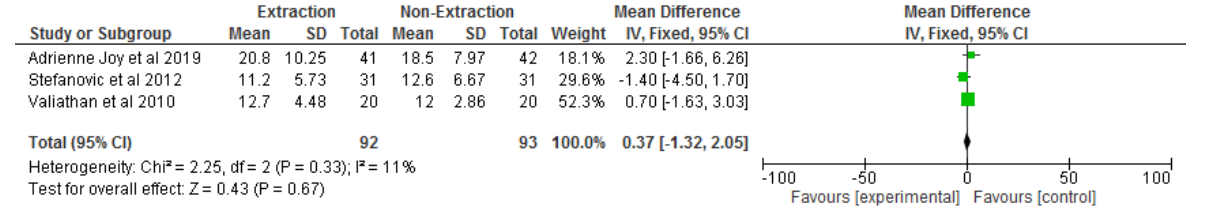
Figure 14. Forest plot for extraction and non-extraction after removing the studies lies outside the funnel.